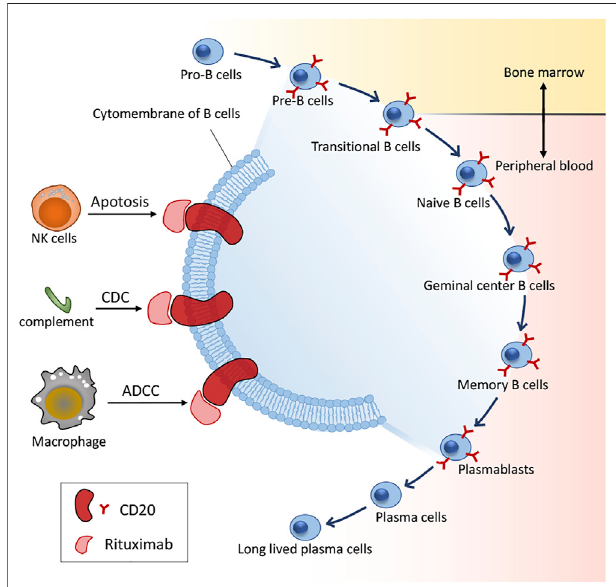
FIGURE 1 | B cell differentiation and action mechanisms of RTX. CDC: complement-dependent cytotoxicity; ADCC: antibody-dependent